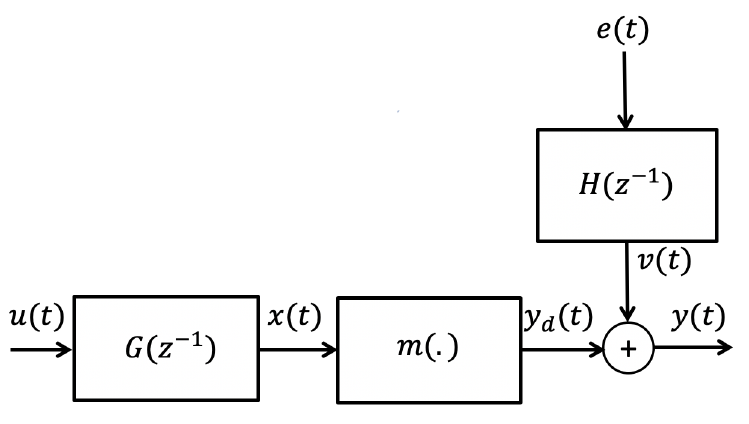
Figure 1. The proposed Wiener Box-Jenkins model